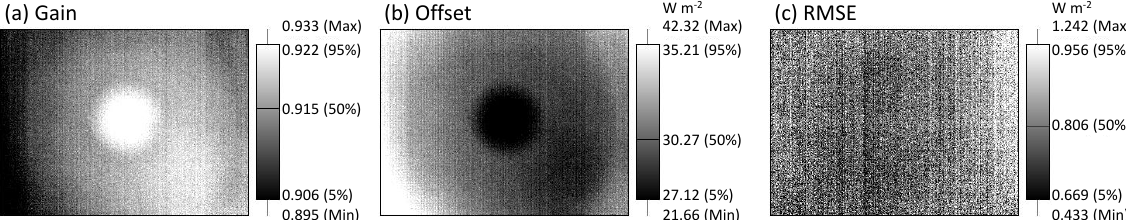
Fig. 3. Radiometric correction parameters for every pixel of the TIR camera system derived from radiometric measurements of a homogenous plate using a reference